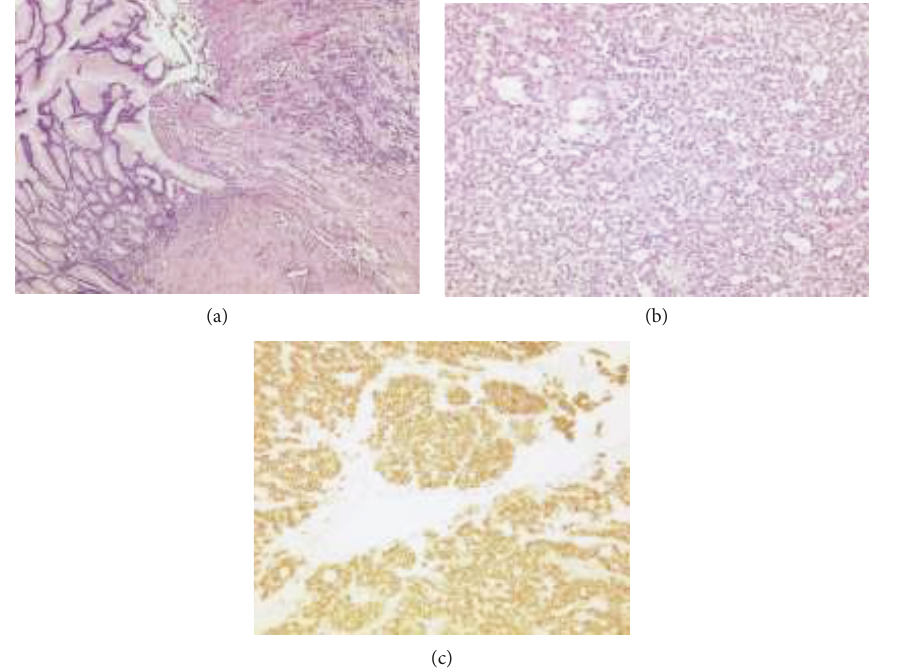
Figure 1: (a) Stomach ulcer with epithelioid GIST (50x, hematoxylin and eosin stain). (b) Gastric epithelioid GIST (100x, hematoxylin and eosin stain). (c) Membrane pattern of KIT immunostaining in epithelioid GIST (100x, CD117).